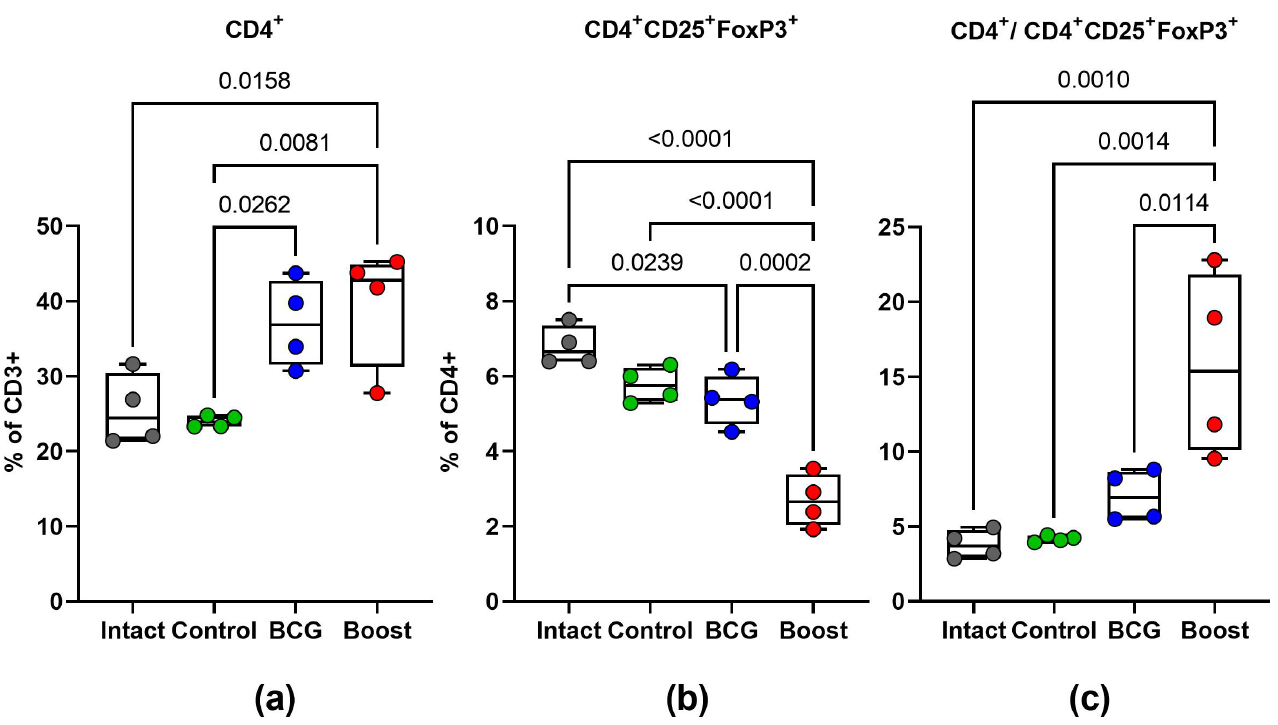
Figure 8. T reg -cell frequency during the M. tuberculosis challenge. Four weeks after the i.v. chal- lenge, relative amounts of CD4 + T cells ( a ), CD4 + CD25 + FoxP3 + T reg cells ( b ), and their ratios ( c ) were evaluated in spleen cells collected from intact mice (gray), non-vaccinated control mice (blue), BCG-vaccinated mice (green), or BCG-vaccinated/TB/FLU-04L-boosted mice (red). The data were considered statistically significant when p < 0.05 in one-way ANOVA with Tukey’s multiple comparisons